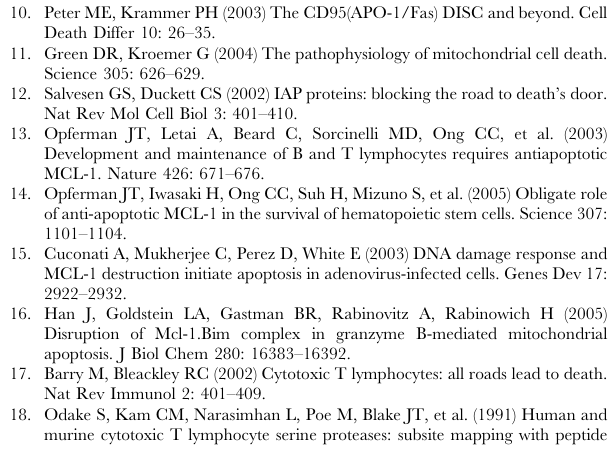
white arrows in the cells depleted of Mcl-1 point to chlamydial inclusions which fail to resist apoptosis. Figure S2 (A) Treatment with LY294002 sensitizes C. tracho- matis infected End-1 cells to staurosporine-induced apoptosis. End-1 cells were infected with C. trachomatis at an MOI of 3 with or without the presence of 10 m M of LY294002. The cells were treated with staurosporine at 24 h post infection. The cells were lysed in sample buffer and the protein levels of cleaved PARP, Mcl-1, pAKT were detected by immunoblot analysis. Actin was used as a loading control and the extent of infection was monitored by checking the Chlamydia Hsp60 levels. (B,C). Cells carrying large inclusions ( . 8 m m) are not sensitized to GrB/LV-mediated apoptosis despite the inhibition of MAPKs. HeLa cells were infected in the presence of MAPK inhibitors at an MOI of 5 for 24 h and induced to apoptosis with GrB/LV. The cells were fixed and stained for Hoechst 3342 to detect the chromatin. Shown are the data from three independent experiments. The bars and error bars represent the mean + / 2 SD. Figure S3 BH3 only proteins are not degraded during C. trachomatis infection. HeLa cells infected with C. trachomatis for various time points were fixed and stained with antisera directed against BAD (A), BID (B), BIM (C) and PUMA (D). Shown are the